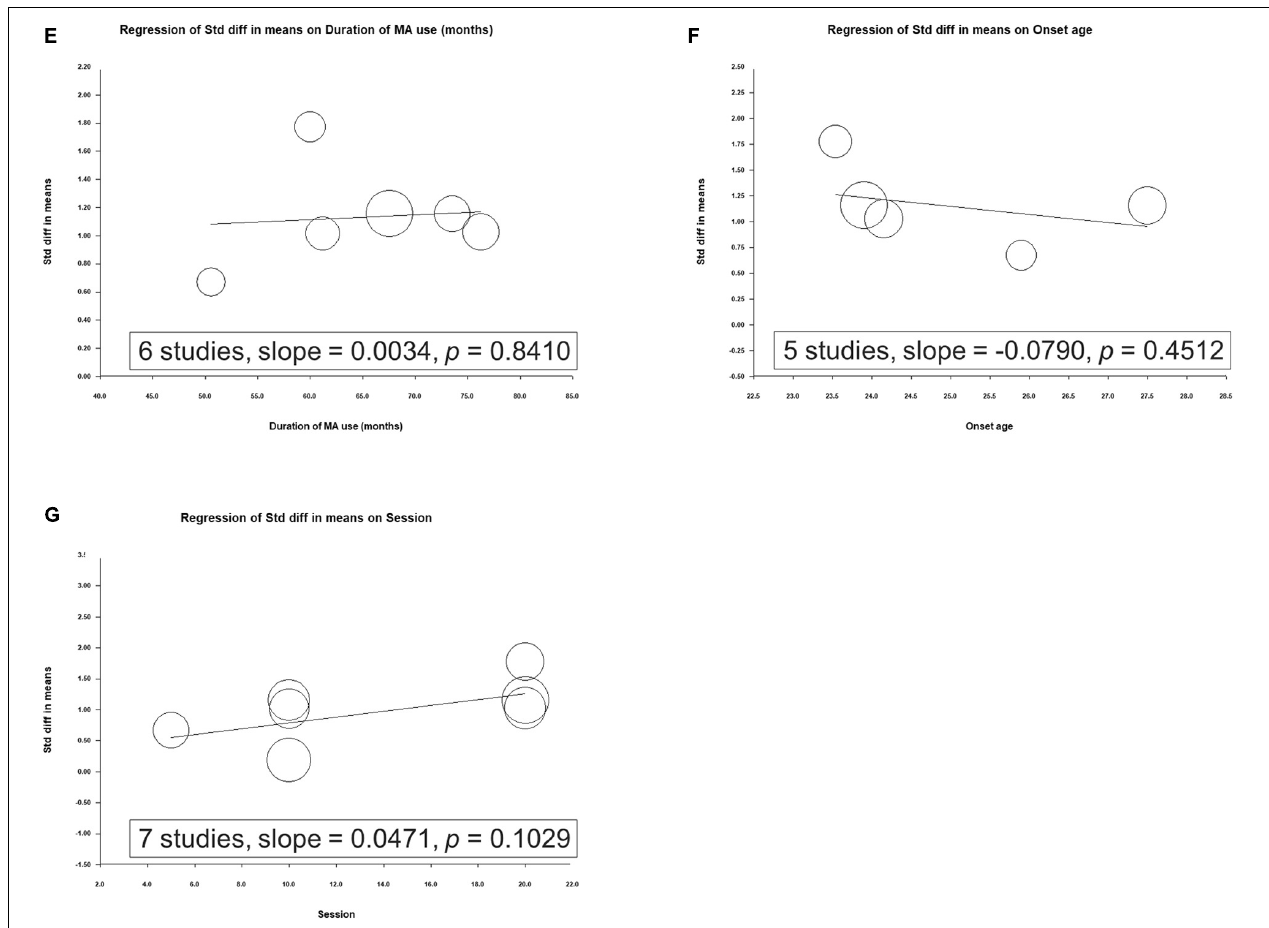
FIGURE 3 | Metaregression of the effects of repetitive transcranial magnetic stimulation on craving in relation to (A) proportion of men, (B) baseline craving scores, (C) duration of abstinence, (D) mean methamphetamine use per day, (E) duration of methamphetamine use, (F) onset age, and (G) number of sessions.